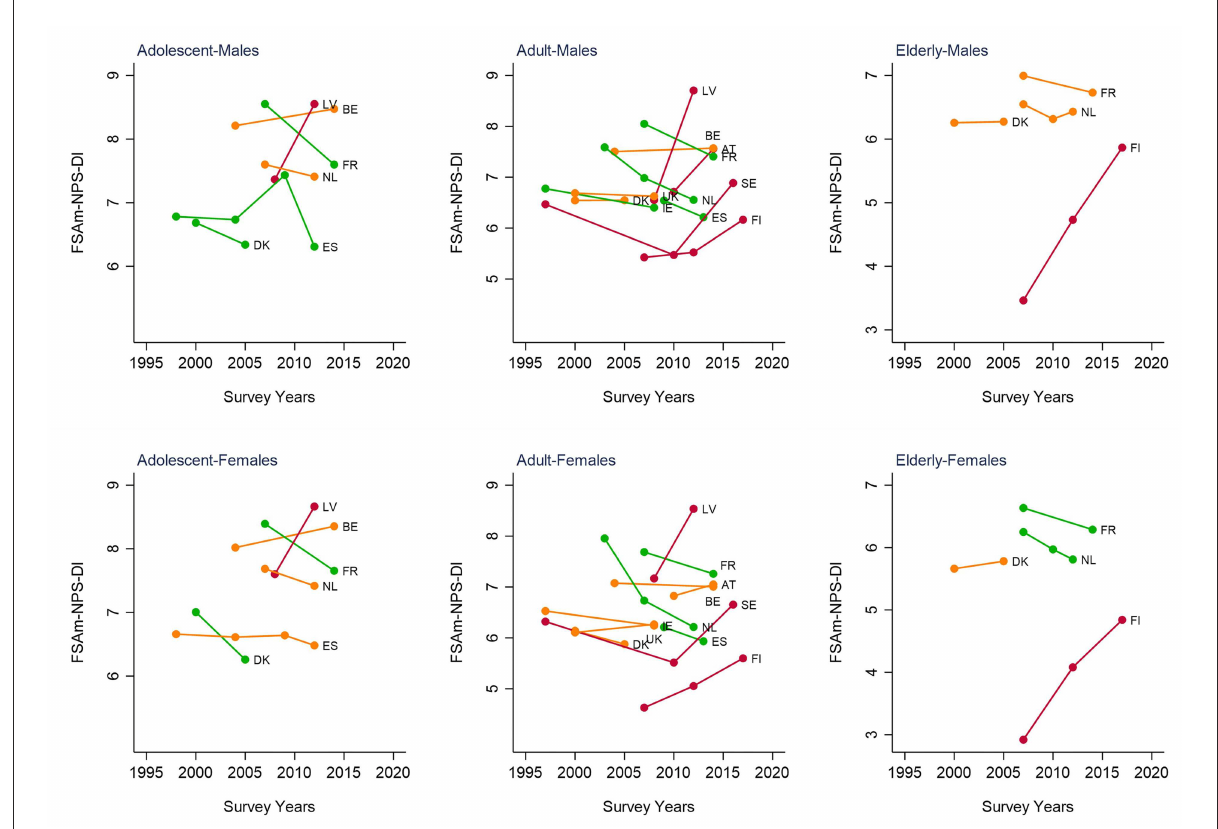
FIGURE3 Time changes of the Food Standard Agency Nutrient Profiling System Dietary Index (FSAm-NPS-DI) 1 in European populations, with recurrent dietary survey intake data available by EFSA, stratified by age-group and sex. AT, Austria; BE, Belgium; DK, Denmark; EN%, energy percentages; ES, Spain; FI, Finland; FR, France; LV, Latvia; IE, Ireland; NL, the Netherlands, SE, Sweden; UK, the United Kingdom. Decrease in FSAm-NPS-DI of 5% or more; change in FSAm-NPS-DI of < 5%; increase in FSAm-NPS-DI of 5% or more. 1 FSAm-NPS-DI is the sum of the FSAm-NPS score for each food or beverage consumed multiplied by the amount of energy provided by that product, divided by the sum of energy intake from all foods and